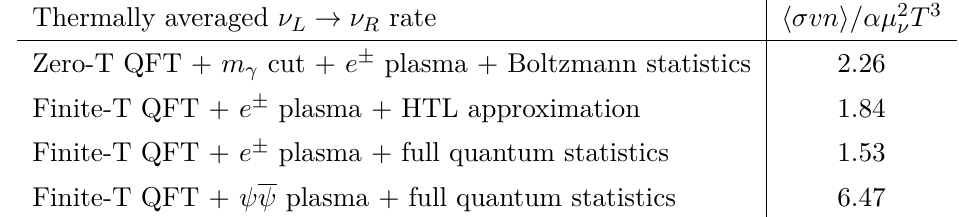
Table 1 . The thermally averaged chirality-flipping rates computed in different methods. “Zero-T QFT + e ± plasma + Boltzmann statistics” denotes the calculation in section 2, where we use Feynman rules of zero-temperature QFT with a finite photon mass cut m γ = eT/ Boltzmann statistics in the relativistic electron-positron ( e ± ) plasma. In the finite-T QFT approach from section 3, finite-temperature effects and full quantum statistics (Fermi-Dirac/Bose-Einstein) are taken into